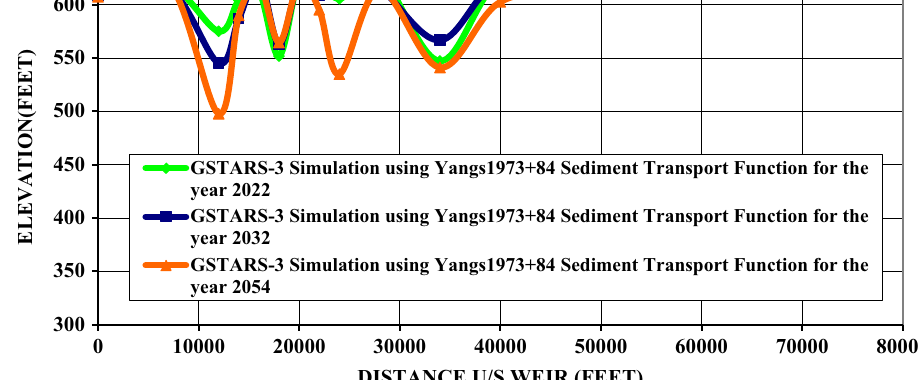
Fig. 7 Simulation results for scenario-2